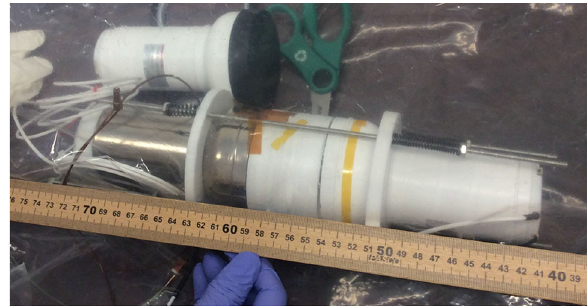
Fig. 2 The detector assembly in a glove bag